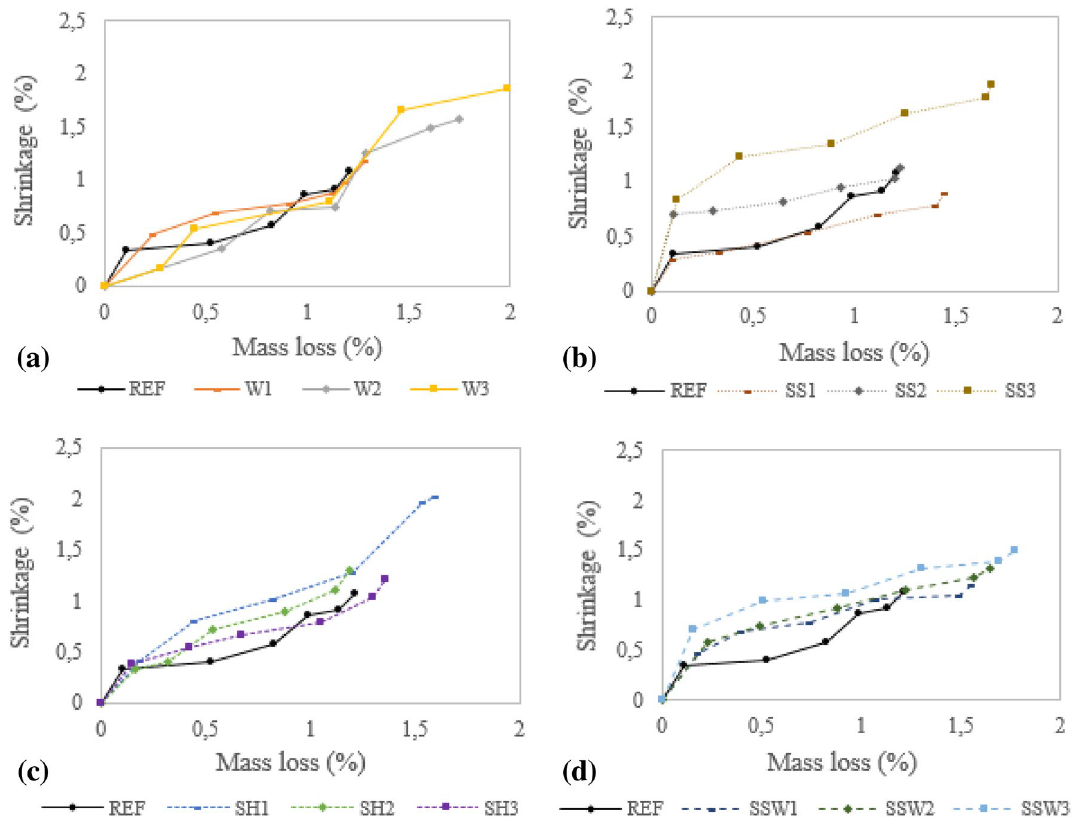
Fig. 5 Comparison of the mass loss and drying shrinkage (%) from a group W, b group SH, c group SSS, and d group SSW